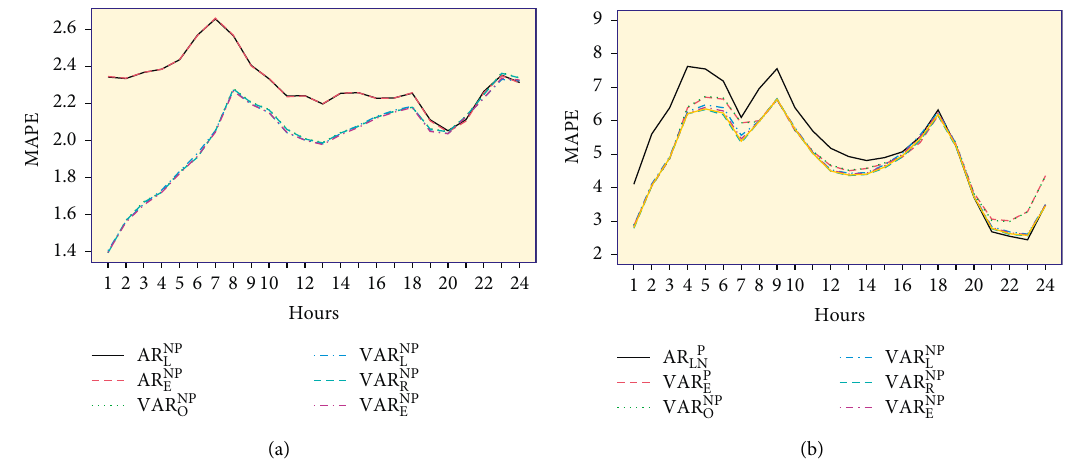
Figure 5: Hourly MAPE for best univariate and multivariate models. (a) Demand and (b) prices.